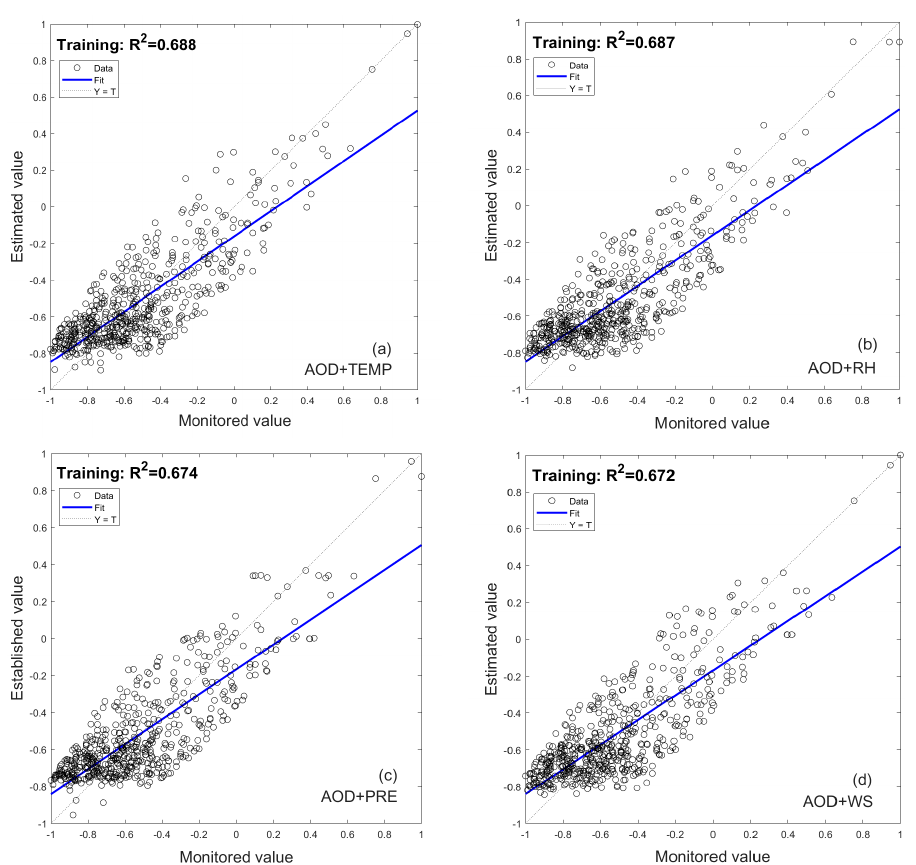
Figure 9. Estimated results of AOD + meteorological factors–PM 2.5 BPNN of training set ( a ), ( a ) AOD + TEMP–PM 2.5 BPNN, ( b ) AOD + RH–PM 2.5 BPNN, ( c ) AOD + PRE–PM 2.5 BPNN, ( d ) AOD + WS–PM 2.5 BPNN.